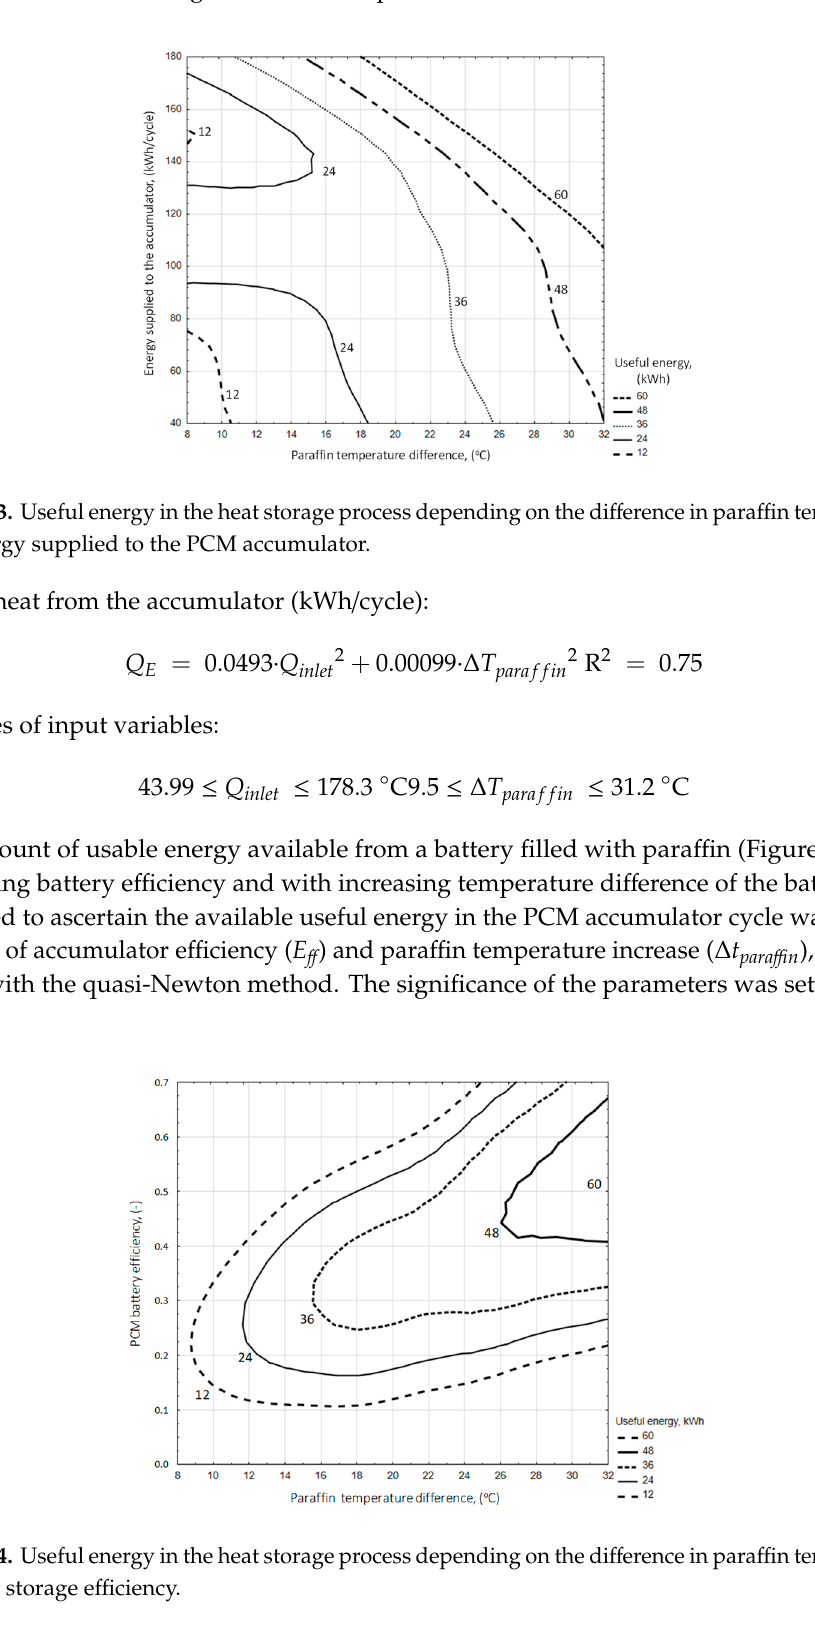
Figure 34. Useful energy in the heat storage process depending on the difference in paraffin temperature and heat storage efficiency.